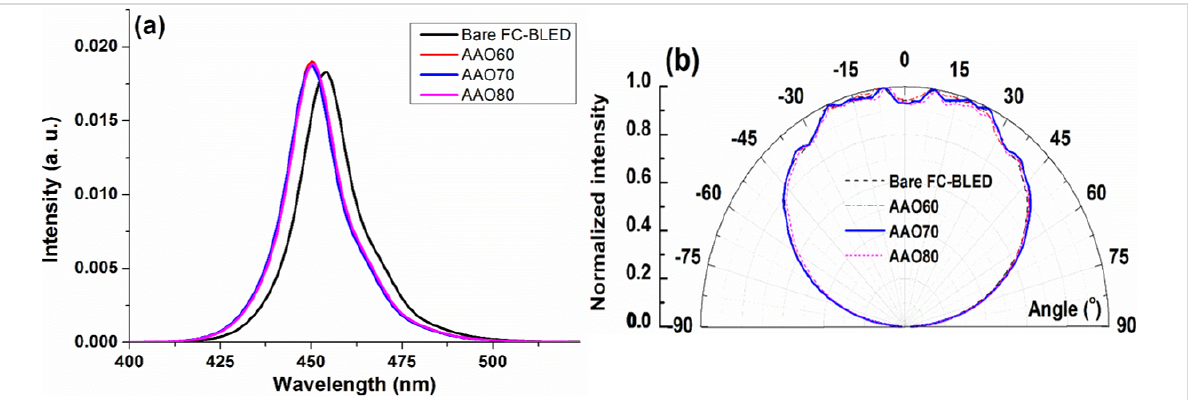
Figure 6: (a) Measured luminous wavelength versus energy and (b) luminous angle for samples AAO60, AAO70, AAO80, and bare FC-BLED.